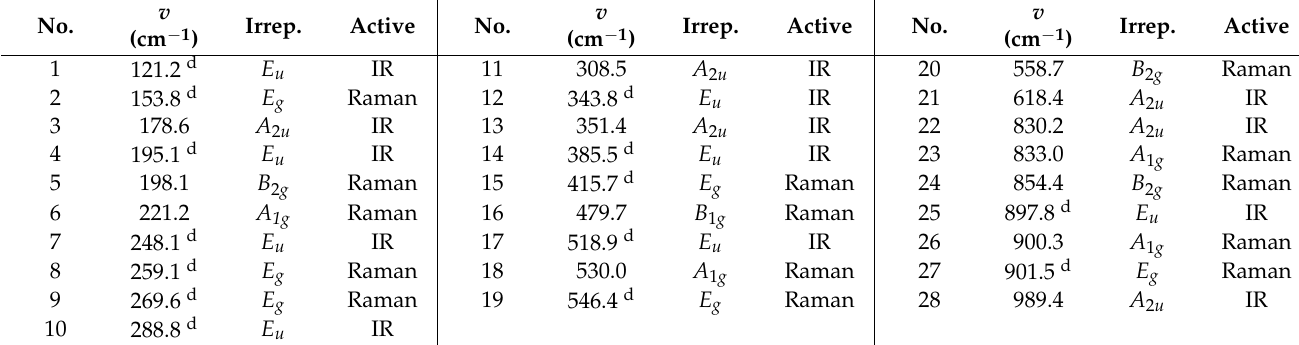
Table 3. Raman and IR frequencies and normal modes of natisite from first-principles